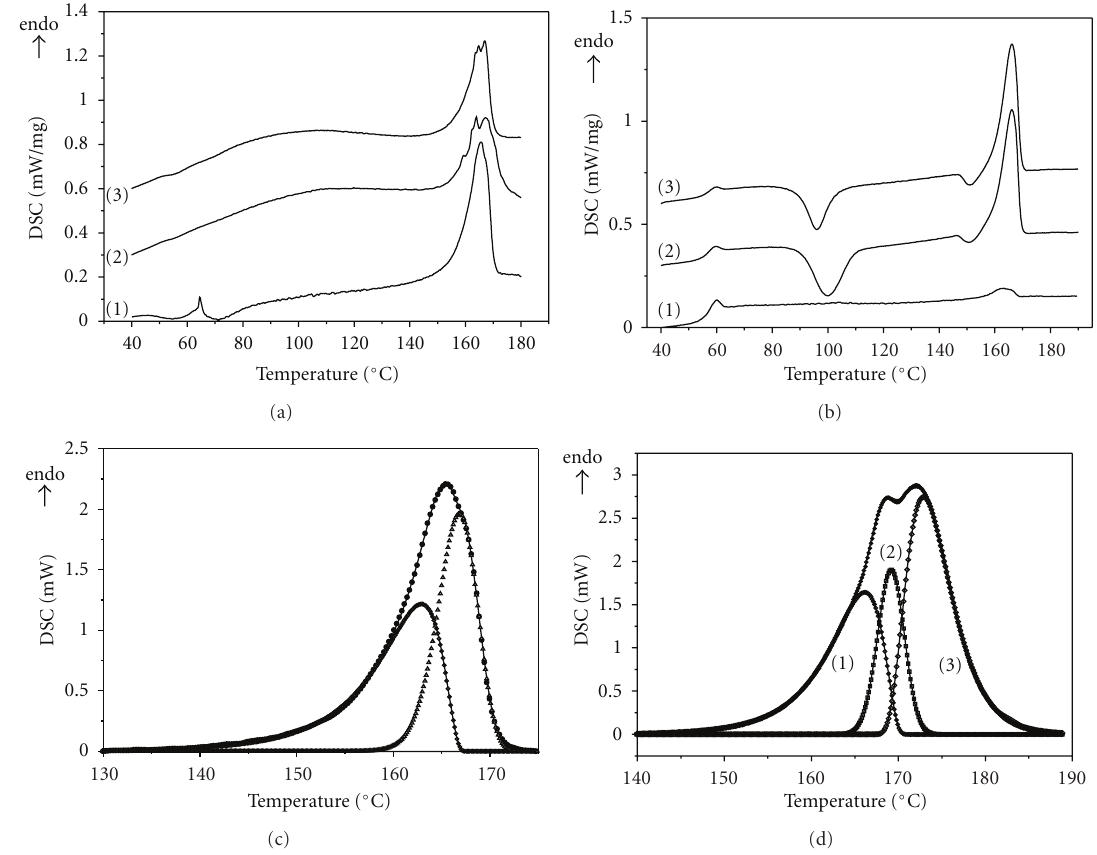
Figure 3: (a) and (b): First heating run (a) and second heating run (b) DSC curves for neat PLLA (1), CPL1/50 ◦ C (2), and CPL1/130 ◦ C (3) samples. DSC thermograms are o ff set along the ordinate for clarity. (c) and (d): Curve fitting and separation of the complex melting endotherm for neat PLLA (c) and for CPL/50 ◦ C sample (d). Partial contributions of the phases into the total endotherm constitute 53.8 and 46.2 relative% (c); 35.5 (1), 17.9 (2) and 46.6 (3) relative% (d)